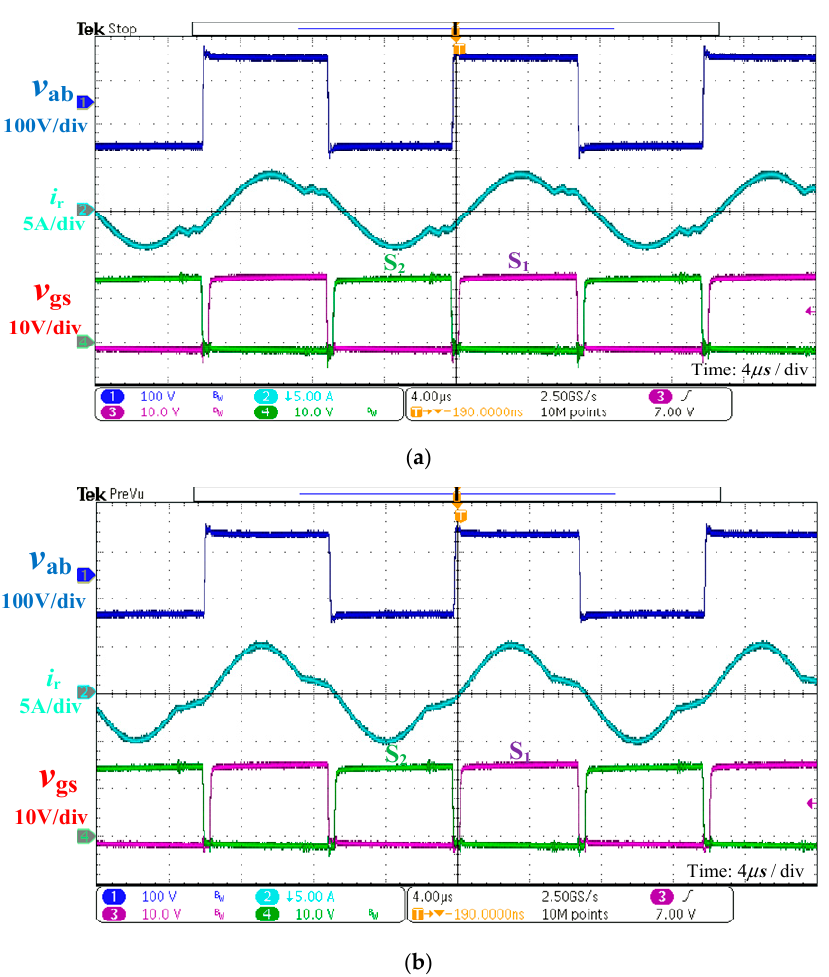
Figure 15. Experimental waveforms under different loads ( f = 71.72 kHz ): ( a ) full load; ( b ) heavy load.